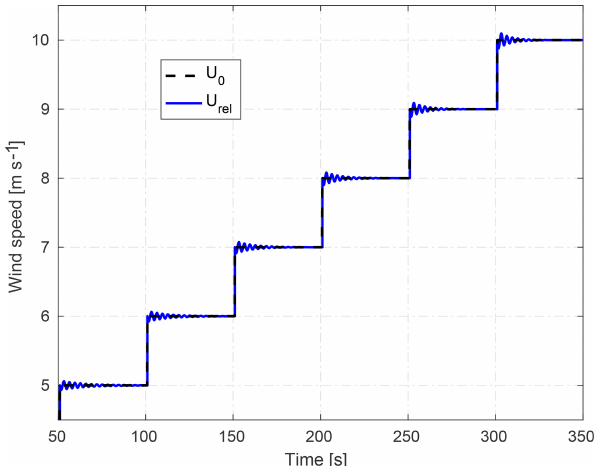
Figure 2. Ramped effective wind speed U 0 and the relative wind velocity U rel , which takes the tower top fore–aft movement into ac- count according to Eq. (5).